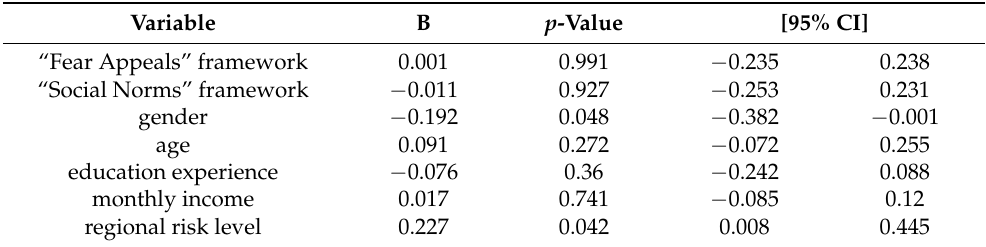
Table A6. Linear regression model of perceived social responsibility on risk communication frame- works, n =